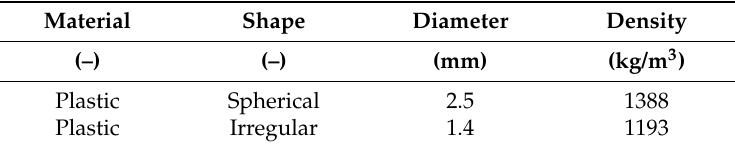
Table 1. Physical characteristics of the tested granular materials.